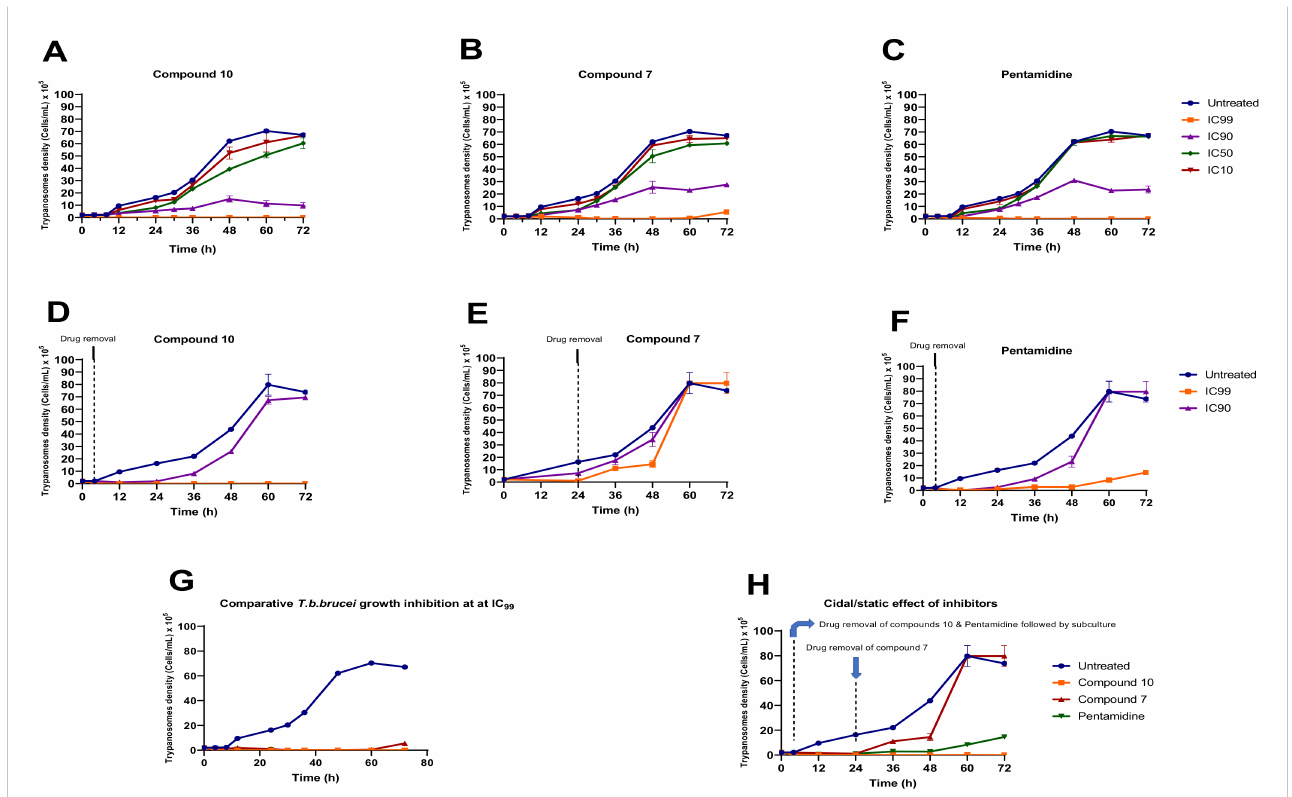
Figure 8. Growth curves of T. b. brucei in the presence or absence of various concentrations of compounds 7 and 10 and pentamidine. Parasites were seeded at 2 × 10 5 cells/mL and incubated for 72 h at 37 ◦ C and 5% CO 2 . ( A – C ) At the indicated time points, trypanosomes were counted microscopically (for IC 10 , IC 50 , IC 90 and IC 99 wells), and the obtained cell counts were averaged and then plotted versus time using GraphPad Prism 8.0. ( D – F ) After treatment for 4 h (analog 10 ) and 24 h (analog 7 ), drugs were washed out from the cultures, and the parasites were subcultured in drug-free complete medium and for an additional 68 h and 48 h for analogs 10 and 7 , respectively. Cells were then microscopically counted, and the counts were used to plot the growth curves over